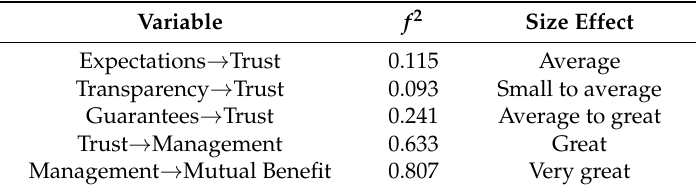
Table 9. Relative explanatory power (size